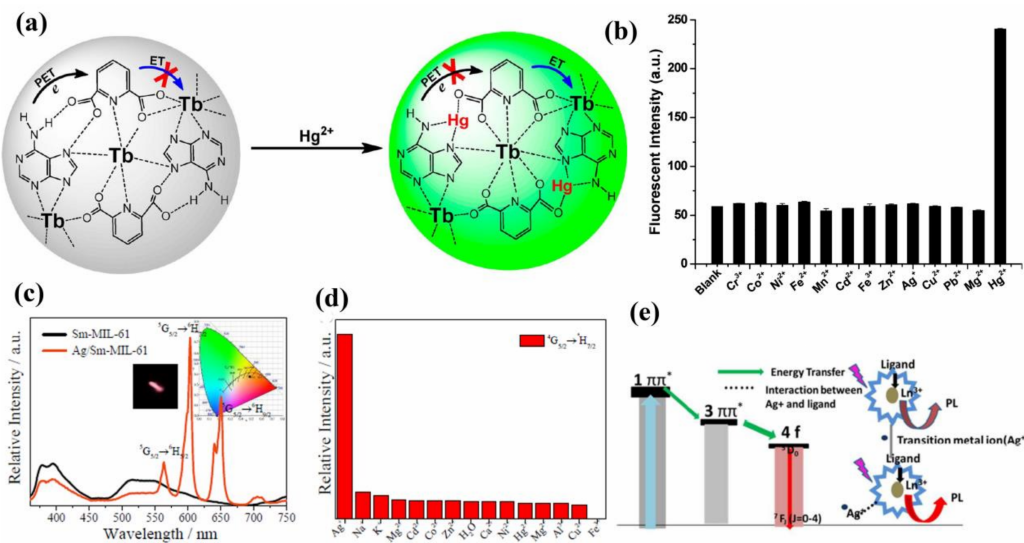
Figure 3. ( a ) Ad/Tb/DPA coordination polymer nanoparticles (CPNPs) for sensing of Hg 2+ by photoinduced electron (PET) transfer; ( b ) Effect of various metal ions (1 µ M) on the fluorescence intensity of Ad/Tb/DPA CPNPs at 545 nm. Reprinted with permission from [72]. Copyright 2012, American Chemical Society; ( c ) PL spectra of Sm-MIL-61 (black line) and Ag/Sm-MIL-61 (orange red line) when excited at 314 nm, the inset shows the CIE chromaticity diagram of Ag/Sm-MIL-61 (x: 0.4804 y: 0.3823) and corresponding photoluminescence color image under UV-] light irradiation at 314 nm; ( d ) The relative intensities of 4 G 5/2 → 6 H 7/2 at 603 nm upon Sm-MIL-61 in the presence of different metal ions; ( e ) Schematic illustration for the energy transfer from ligand to Ln 3+ center. Reprinted